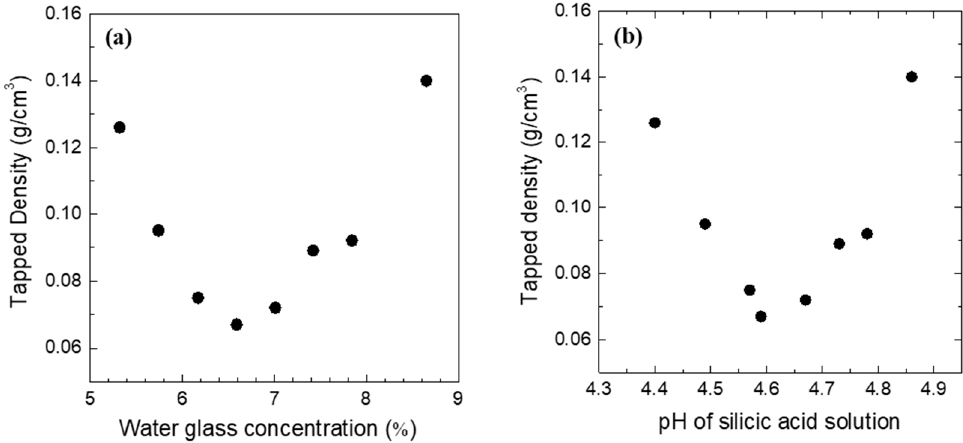
Figure 2. Tapped density of spherical silica aerogel powder as a function of water glass concentra- tion ( a ) and pH of silicic acid solution ( b ). ( a ) and pH of silicic acid solution ( b